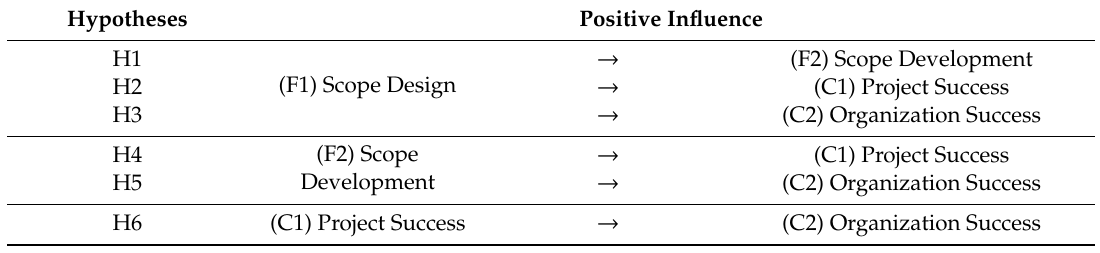
Table 12. Hypotheses.